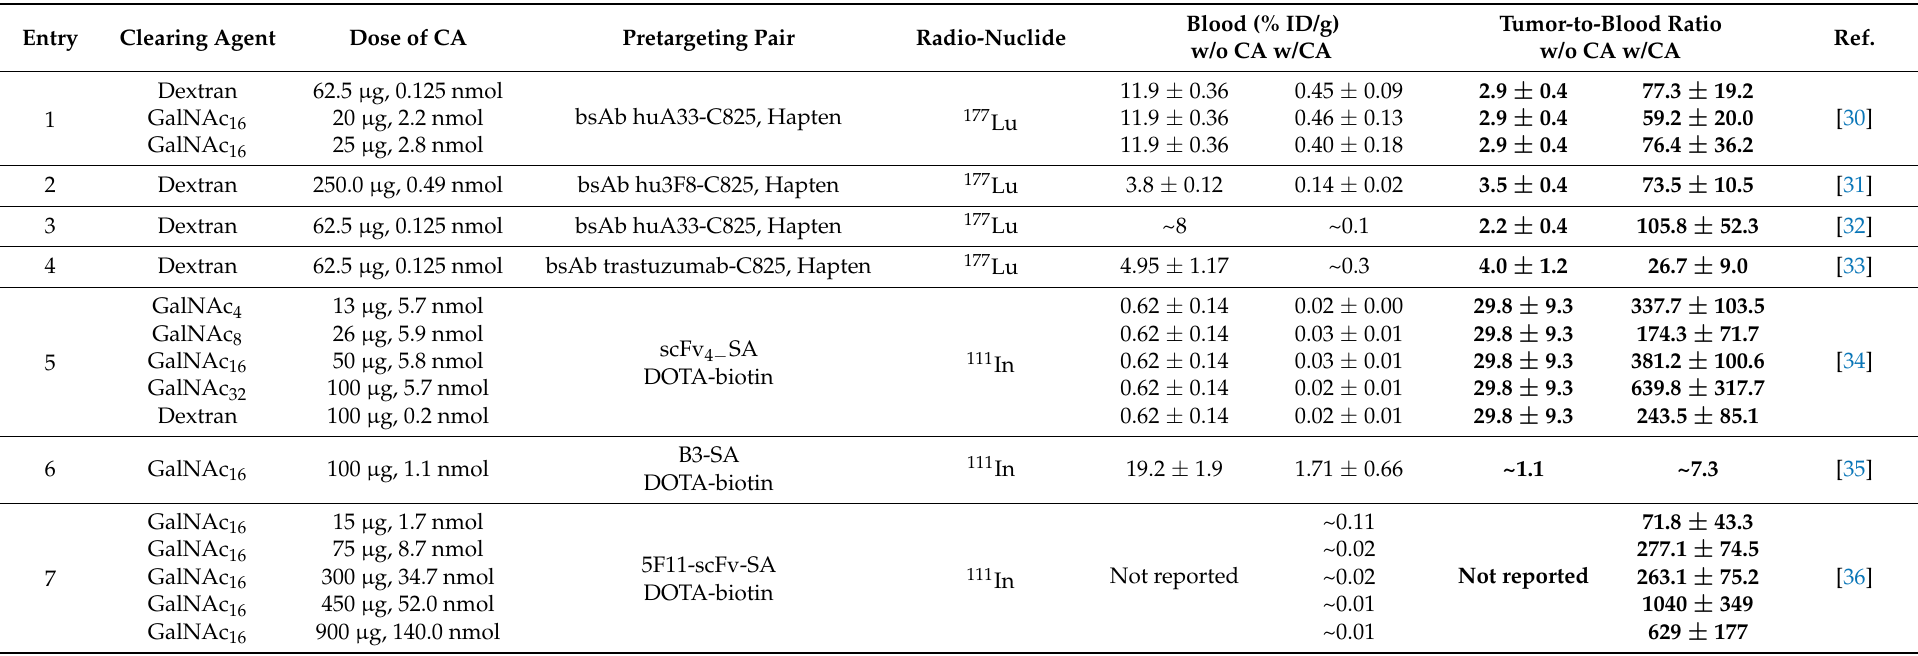
Table 1. Overview of carbohydrate-based clearing